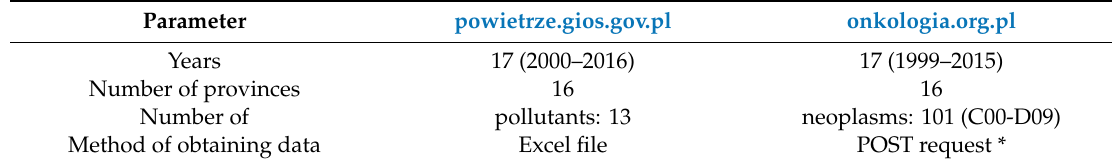
Table 2. Data available from the website powietrze.gios.gov.pl and onkologia.org.pl. Parameter powietrze.gios.gov.pl